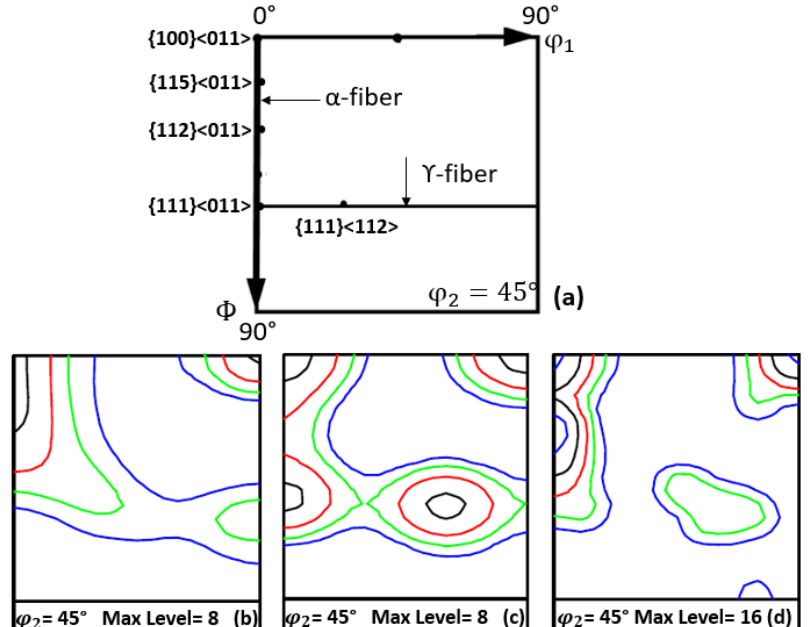
Figure 10. ( a ) Orientation distribution function section with select fibers and orientations in BCC metals. Ferrite textures of superduplex stainless steel are presented in the same section for the ( b ) industrial, ( c ) ultrafine and ( d ) equiaxed microstructures.